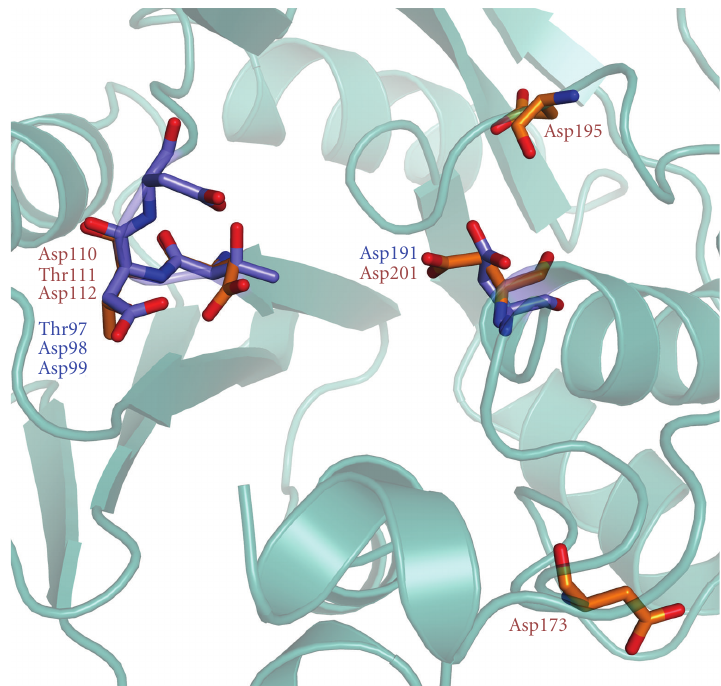
Figure 5: Homology modeling of Hfx. volcanii AglD residues based on the available three-dimensional structure of B. subtilis SpsA. Structural modeling was performed by using the SWISS-MODEL program (http://swissmodel.expasy.org/) and visualized using PyMol (http://www.pymol.org/). B. subtilis SpsA Thr97, Asp98, Asp99, and Asp191 are shown in blue, while Hfx. volcanii AglD Asp110, Thr111, Asp112, Asp173, Asp195, and Asp 201 are shown in brown. The ribbon diagram in the background corresponds to the three-dimensional structure of SpsA [20]. The RMS value, reflecting the quality of the homology modeling, is 0.61